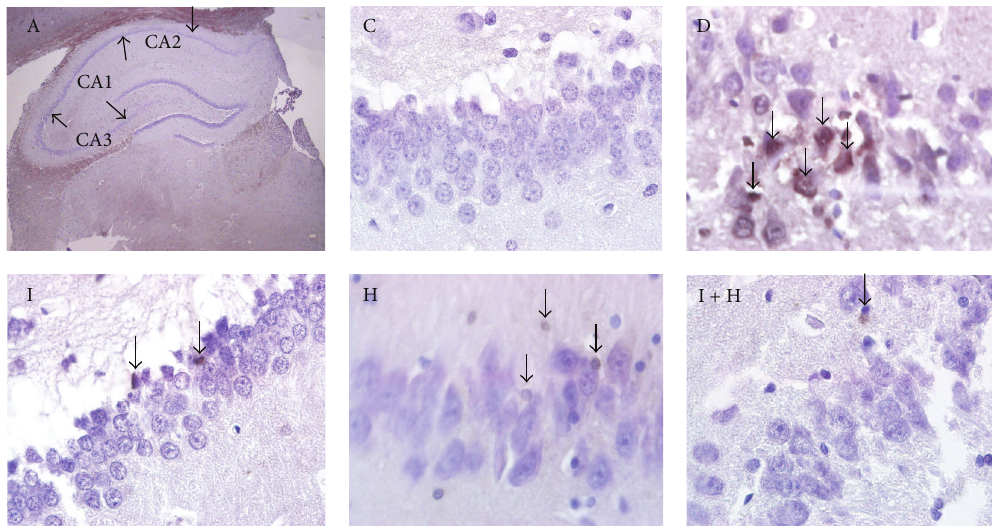
Figure 3: Effects of insulin and honey on apoptosis of neuronal cells in the hippocampus. Apoptosis was evaluated via TUNEL assay with the use of in situ Cell Death Detection Kit at 400x magnification (arrows show the apoptotic cells). A: different parts of hippocampus; C: the control group; D: untreated diabetic group; I: diabetic rats treated with insulin; H: diabetic group treated with honey; I + H: diabetic rats treated with insulin and honey simultaneously.